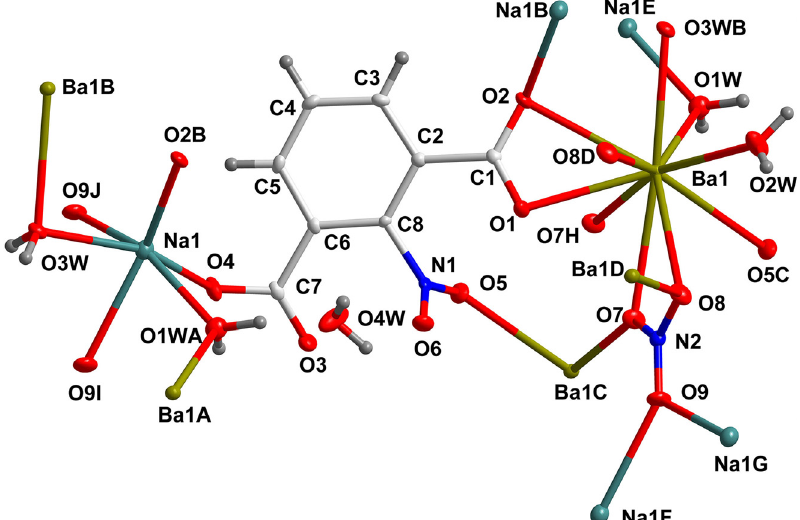
Table  : Data collection and